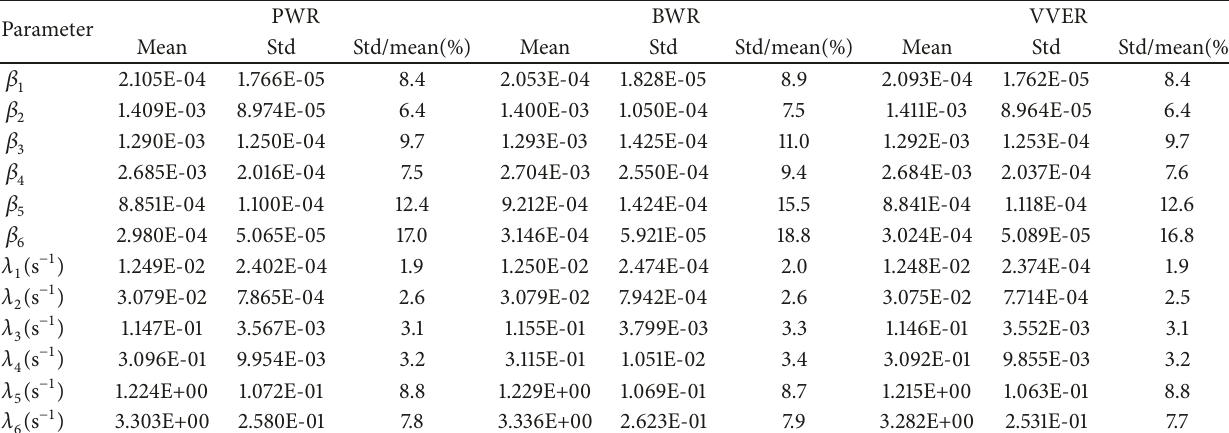
Table 7: Summary of kinetic parameters’ values and uncertainties at BOL for various LWR lattice models in UAM benchmark. PWR BWR Parameter